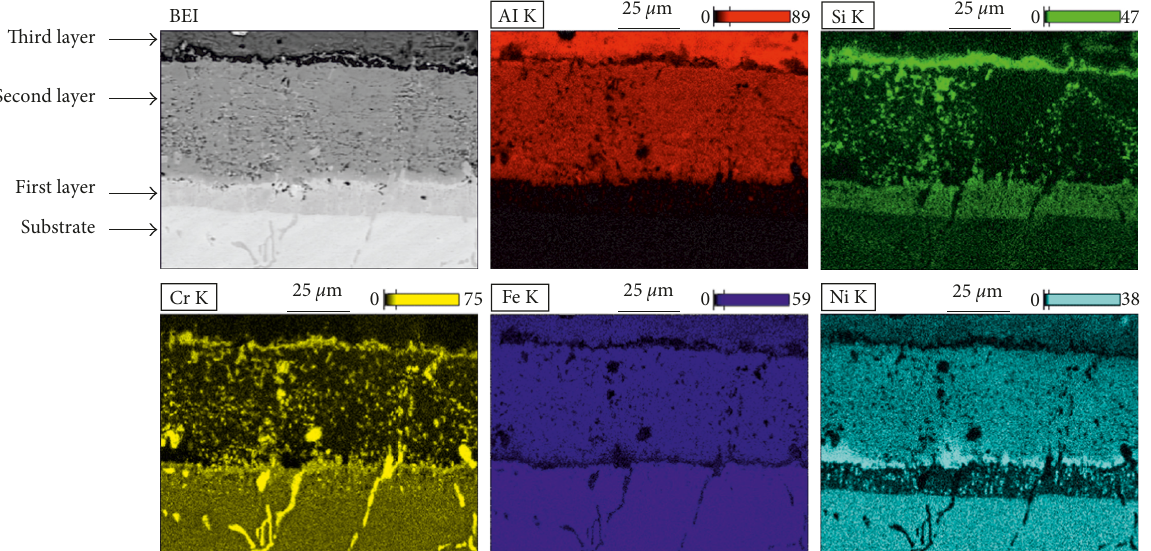
Figure 5: Elemental mapping in a cross section in coating number 17 (technological parameters 900 ° C, 7.5 h, Al/Si � 9; central point of the experiment).